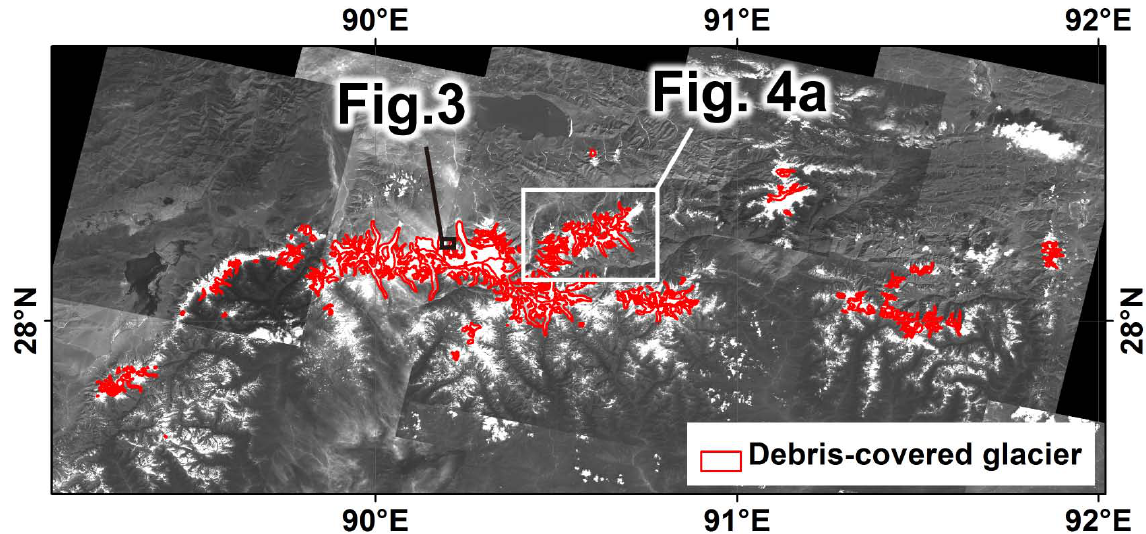
Fig. 1. Spatial distribution of 213 debris-covered glaciers in the Bhutan Himalaya. The background image is a mosaic of AVNIR-2 images.